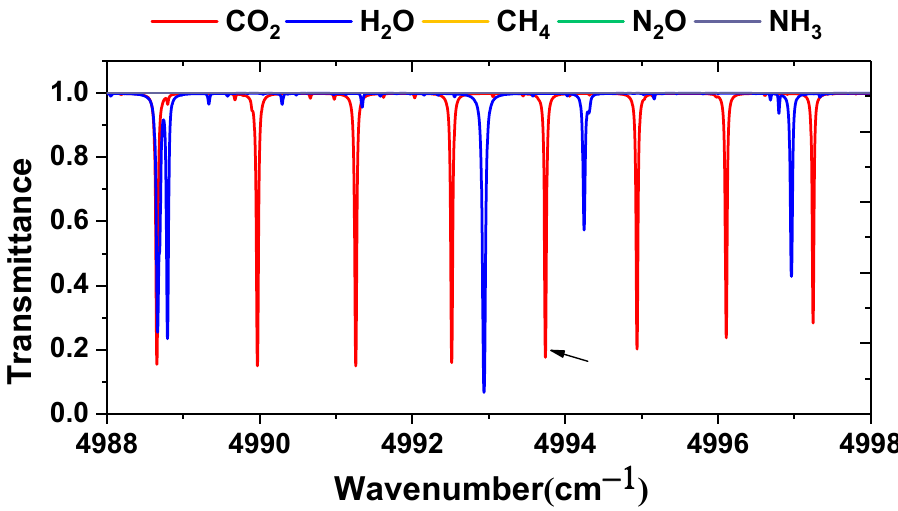
Figure 2. HITRAN simulation of the real atmosphere spectrum near 2 μ m. Simulation conditions: temperature 296 K; pressure 90 Torr; absorption light path 407.4 m. (CH 4 2 ppm, CO 2 400 ppm, H 2 O 1.8%, N 2 O 320 ppb, NH 3 20 ppb). The black arrow indicates the CO 2 absorption line at 4993.7431 cm − 1 selected during the measurement.